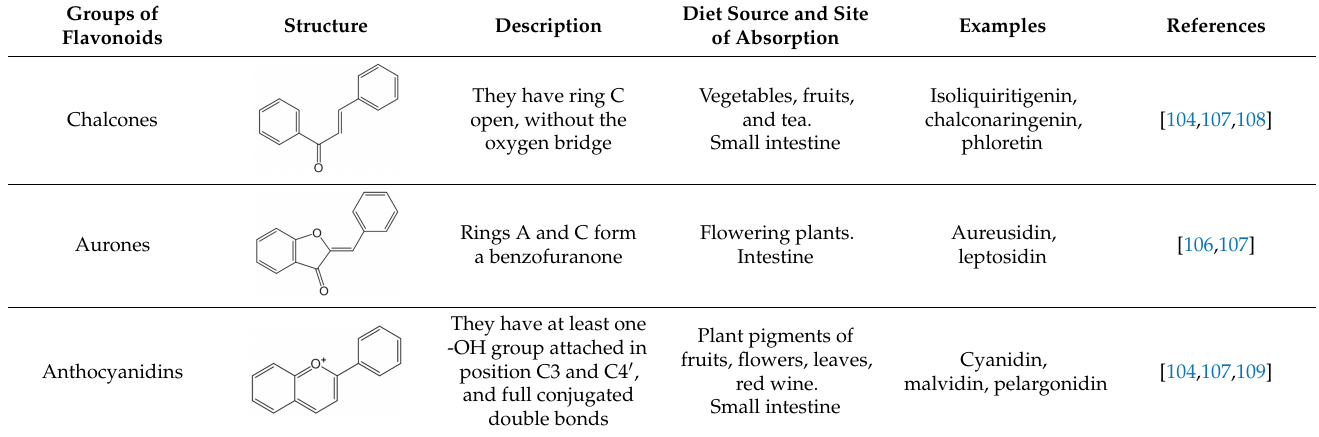
Table 3. Groups of flavonoids, general